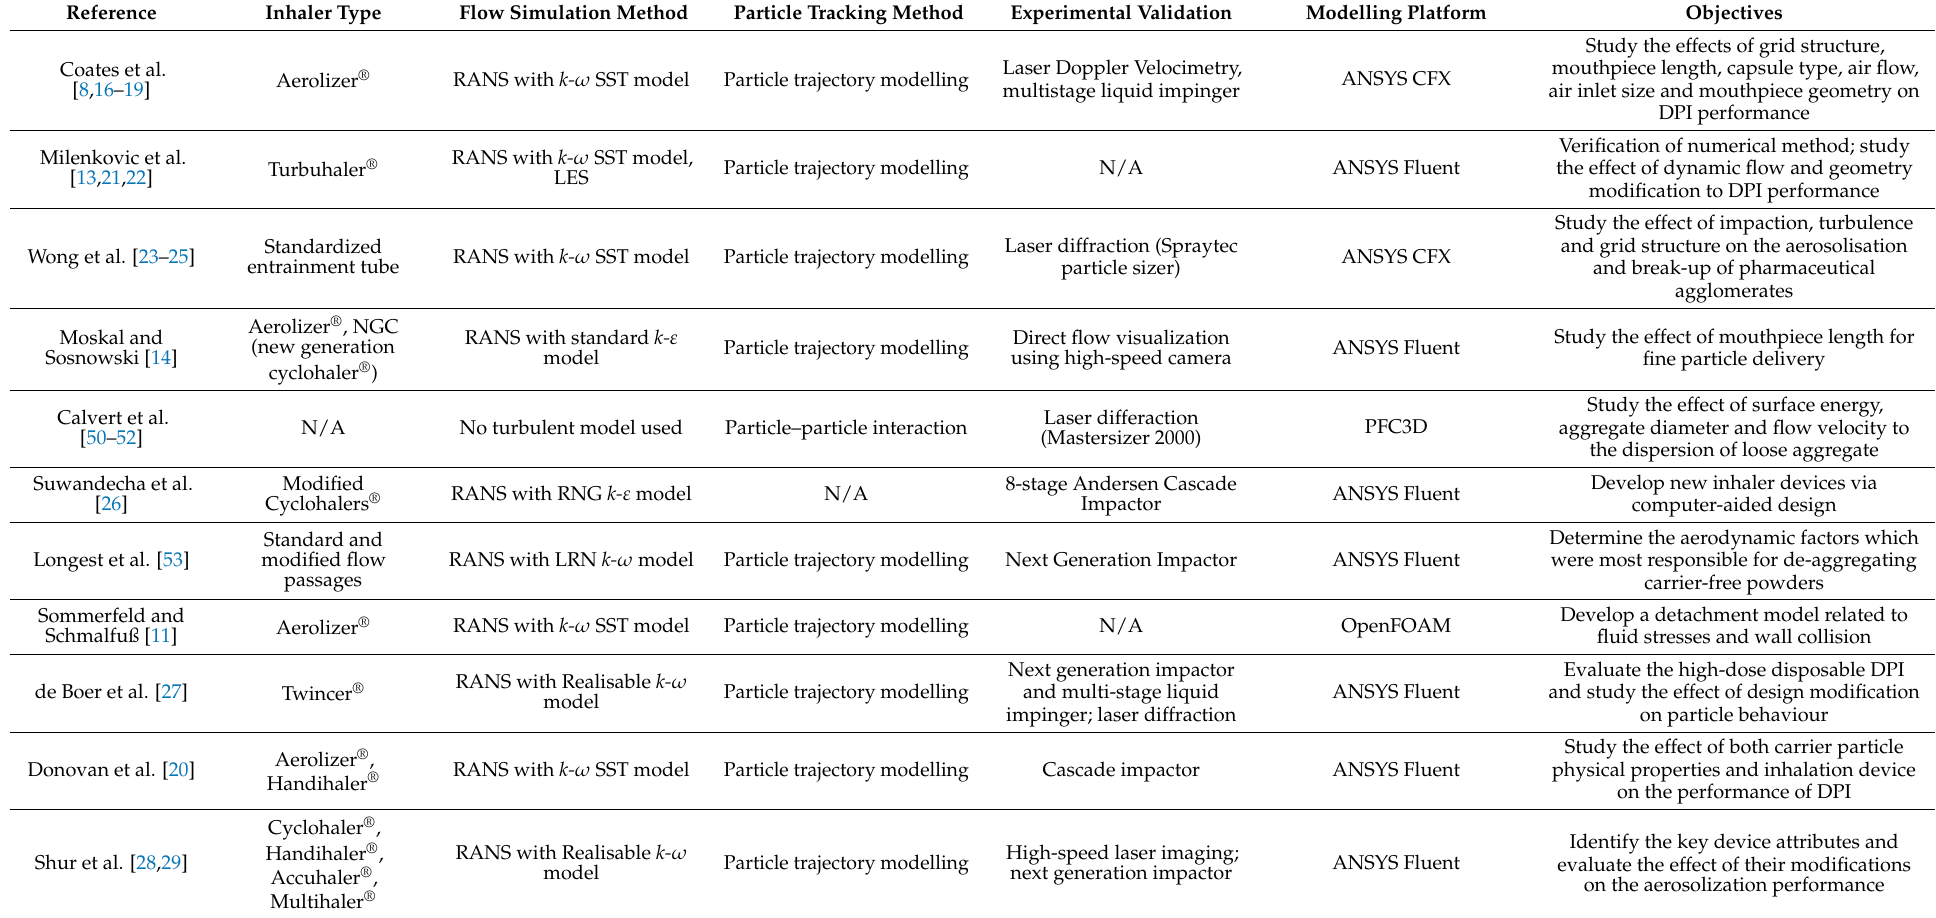
Table 2. Summary of numerical studies of flow field and particle tracking for DPI